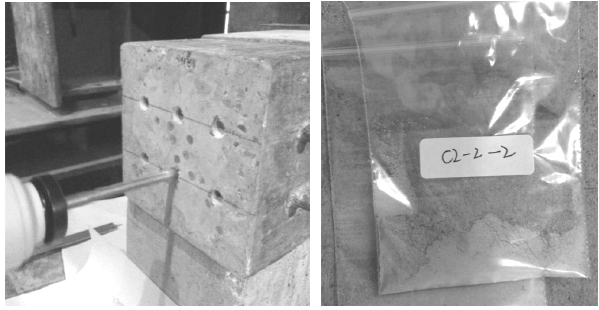
Figure 8. Extraction of concrete block powder.